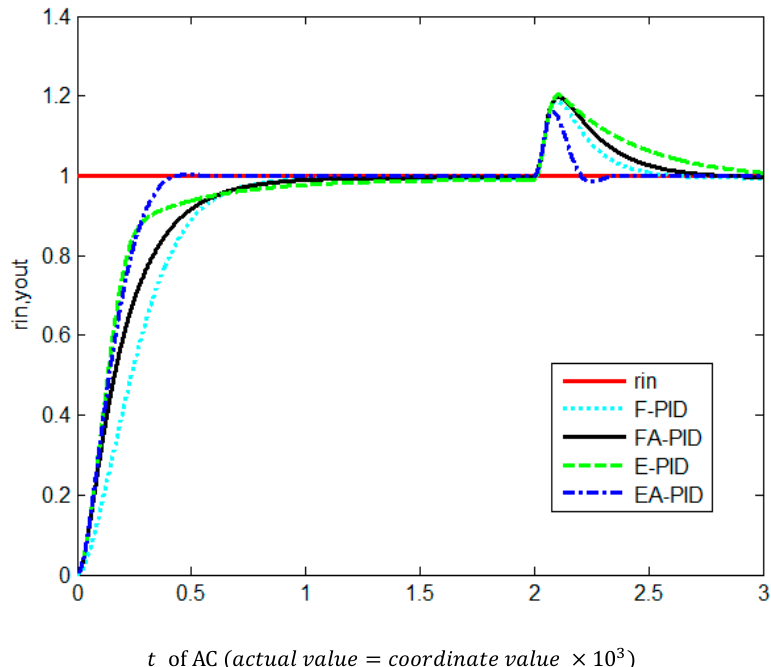
Figure 8. Results of the situation of unsaturation of four AI-CC systems.